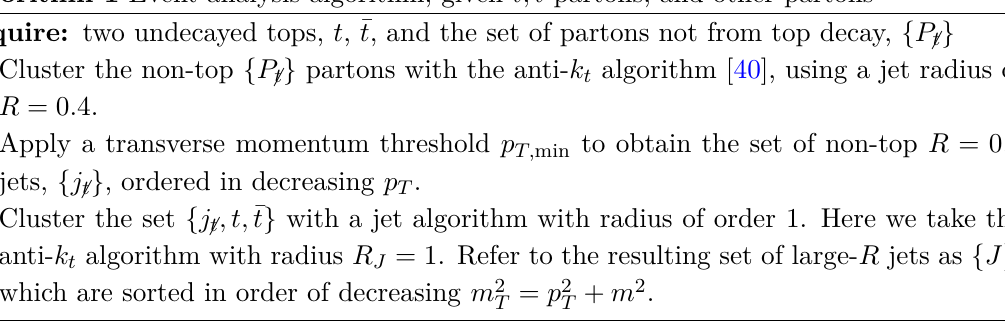
Algorithm 1 Event analysis algorithm, given t, Require: two undecayed tops, t ,